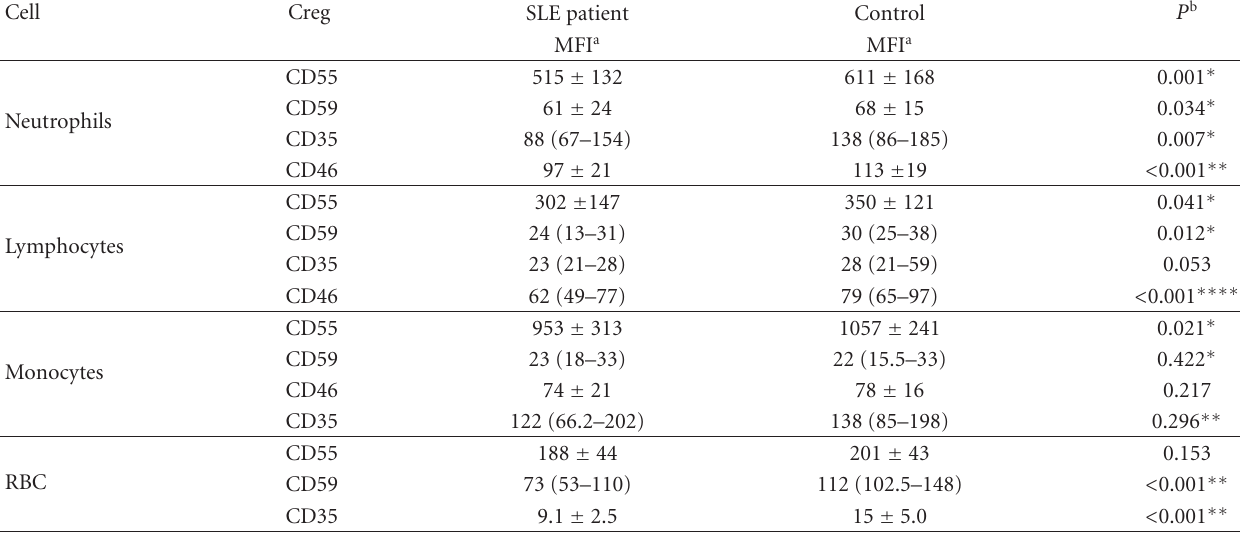
Table 2: The mean of membrane fluorescence intensity (MFI) of CD55, CD59, CD46, and CD35 on the blood cells of SLE patients and